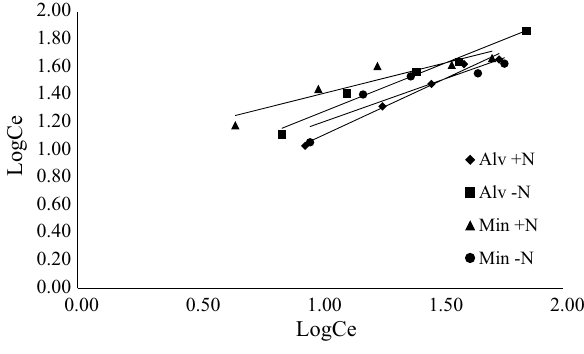
Fig. 12 Freundlich isotherm for cadmium ions onto N. alveolaris + N, N. alveolaris –N, N. minuta + N, and N/ minuta –N algae